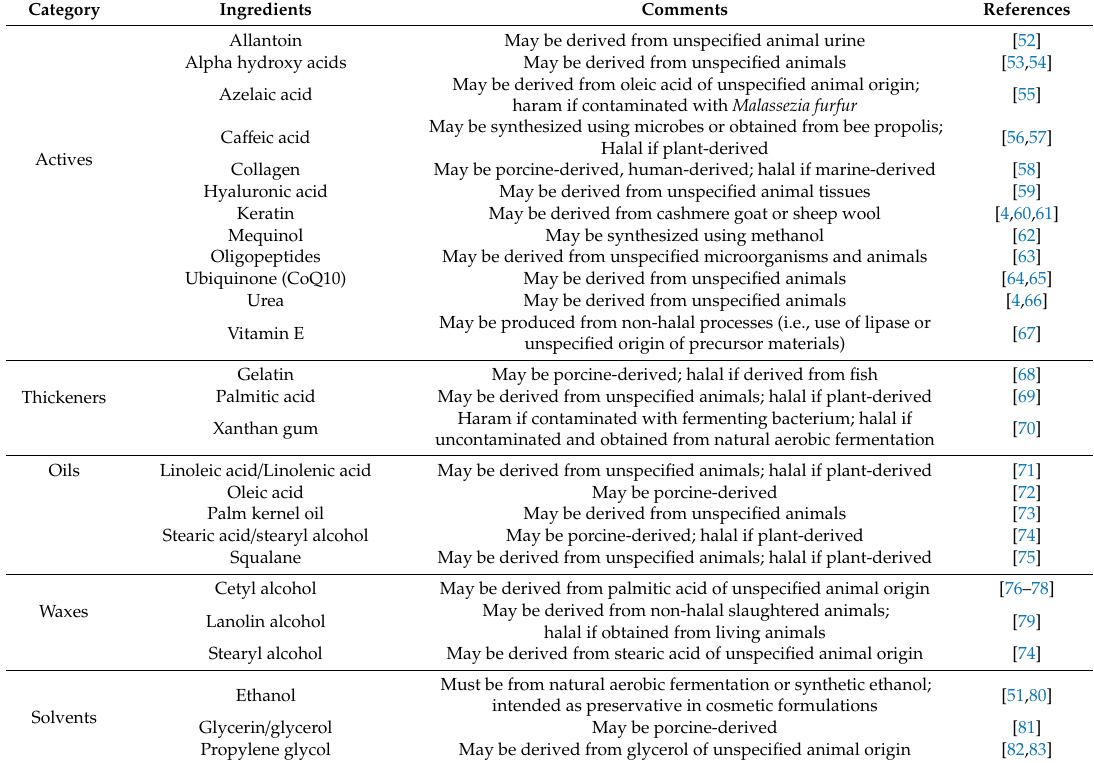
Table 3. Critical cosmetic